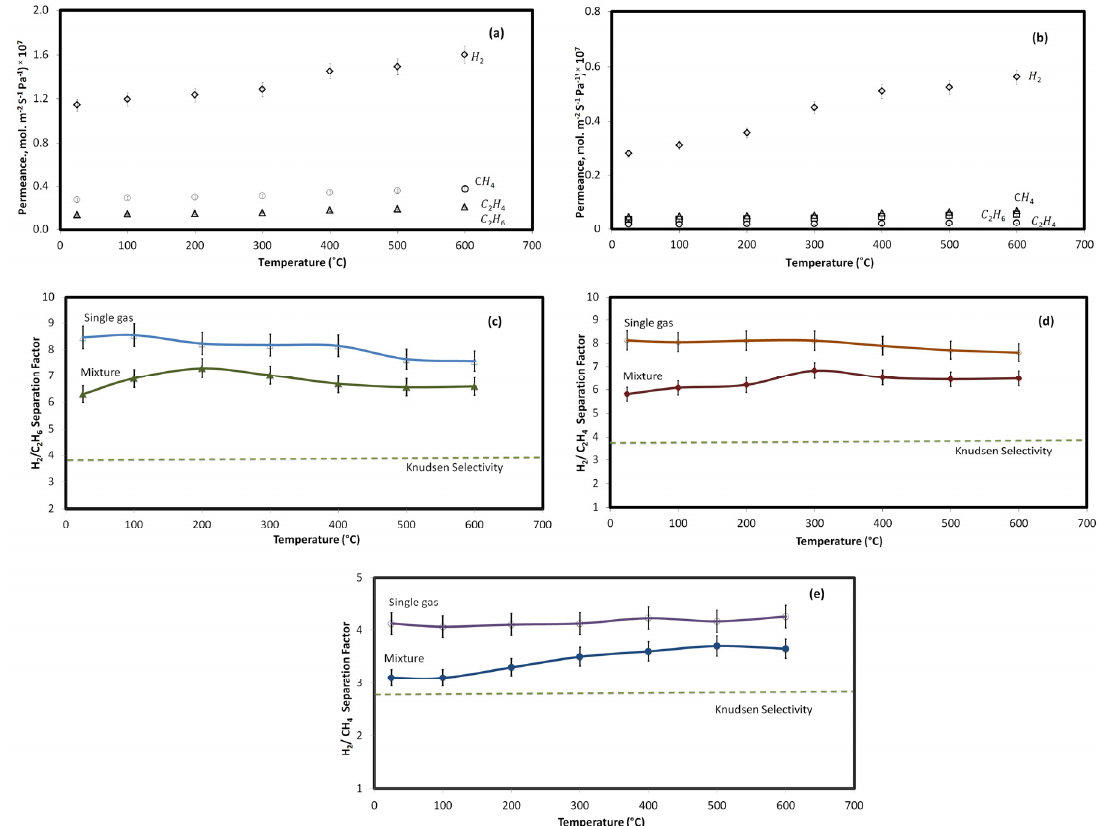
Figure 4. Permeance of ( a ) single gas and ( b ) mixed gas, and selectivity values for ( c ) H 2 /C 2 H 6 ; ( d ) H 2 /C 2 H 4 , and ( e ) H 2 /CH 4 in multicomponent (closed symbols) and single gas (open symbols) permeation tests at different temperatures, constant feed, and permeate pressures (111.2 kPa and 101.3 kPa, respectively).